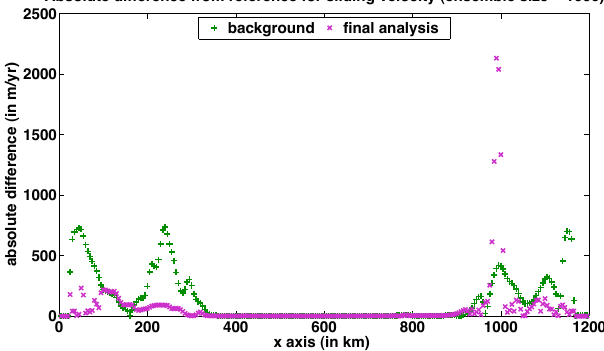
Fig. 9. Absolute difference between analysis and reference (in pur- ple x) after 20 years of the 1000-member ETKF is compared to the absolute difference between background and reference (in green crosses) for bedrock topography. The average RMS error is de- creased from 207.5m for the background to 45.9m for the analysis and the maximum absolute difference from 671.6 to 150.5m.